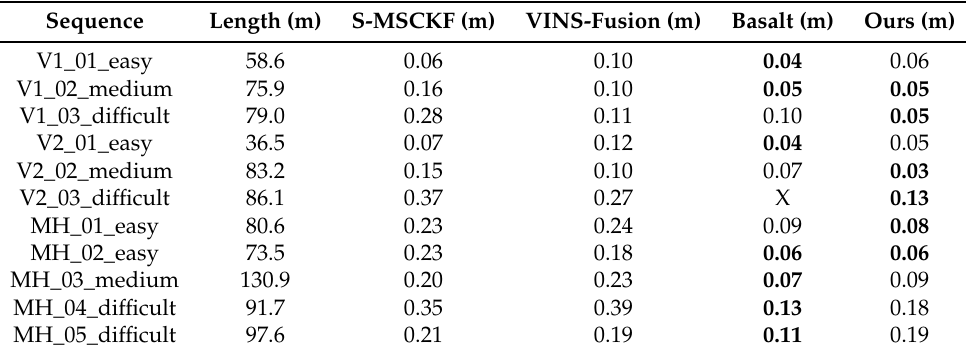
Table 1. Root Mean Square Errors (RMSE) of absolute trajectory error for S-MSCKF, VINS-Fusion, and Basalt compared with our algorithm on the EuRoC dataset. The bold text results are shown to be the best and X is fail to